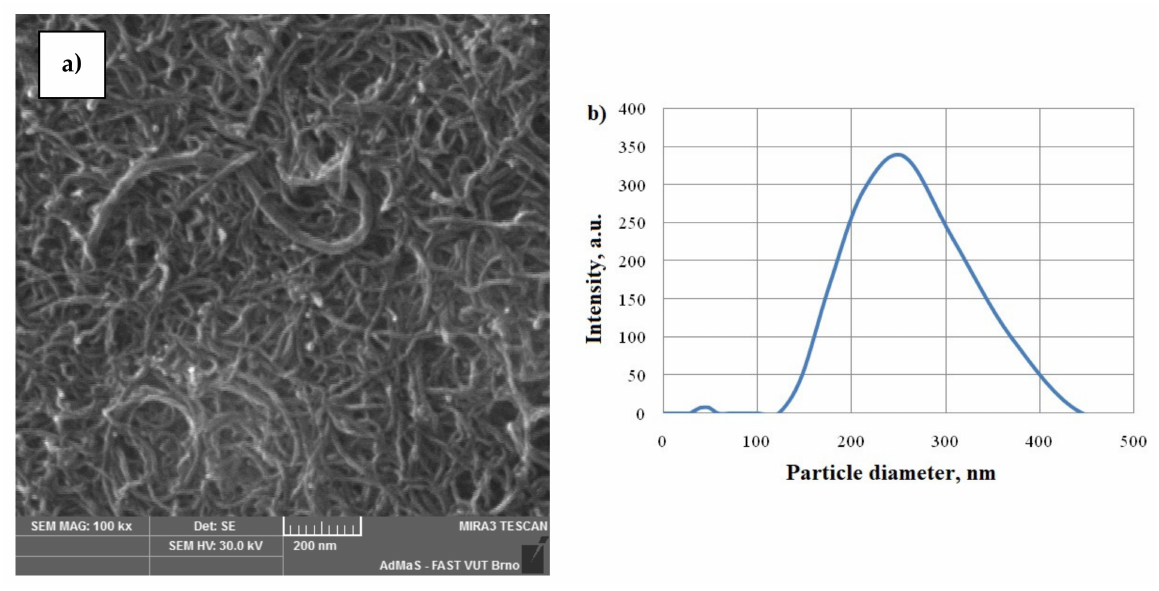
Figure 1. MWCNT suspension: ( a ) general view in an SEM image ( × 100,000); ( b ) dispersion analysis.